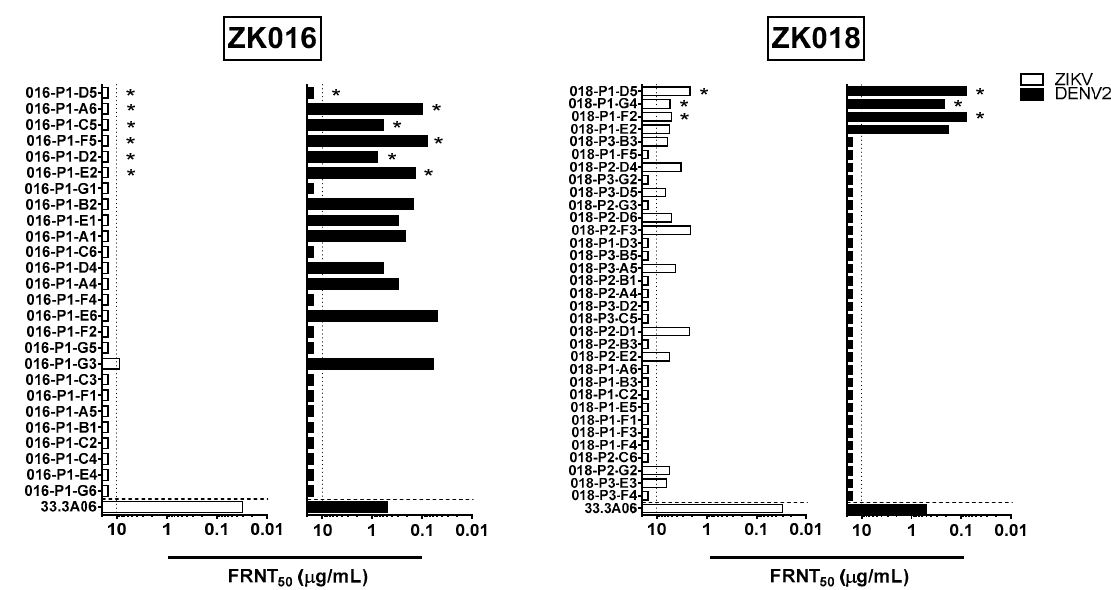
Figure 5. Plasmablast-derived mAbs from dengue-experienced individual preferentially neutralize DENV compared to ZIKV. The mAbs generated from patient ZK016 ( left panels) and ZK018 ( right panels) were tested for neutralization activity against ZIKV (white bar) and DENV2 (black bar). FL-specific mAbs are indicated by asterisks. The values plotted represent mAb concentration required for 50% reduction of viral foci, termed FRNT50. The vertical dotted lines indicate the maximum concentrations of mAb tested (10 µg/mL). The horizontal dotted line separates the positive control, dengue plasmablast-derived mAb 33.3A06 reported previously [33]. The results plotted are mean values from two or more independent experiments.